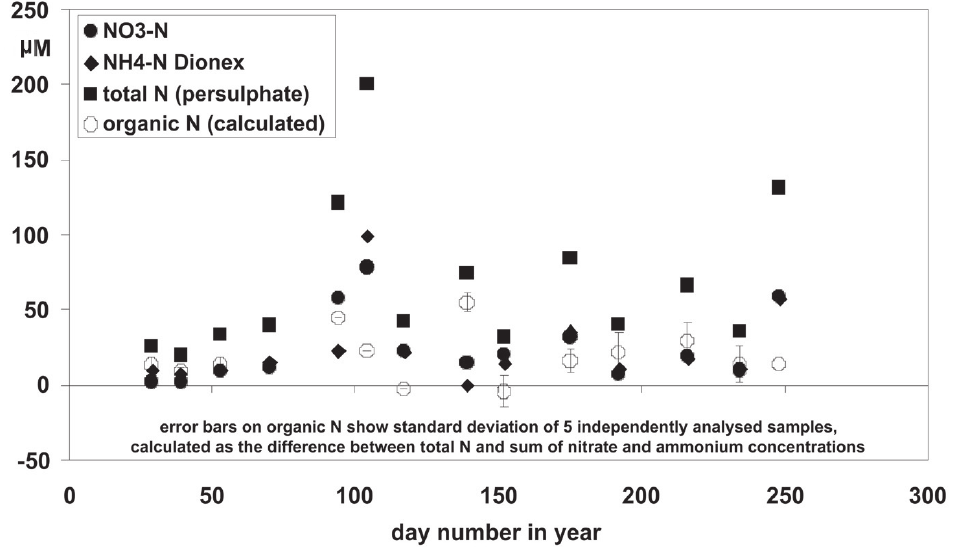
FIGURE 4 . Concentrations of dissolved N in rain, Bush Estate,